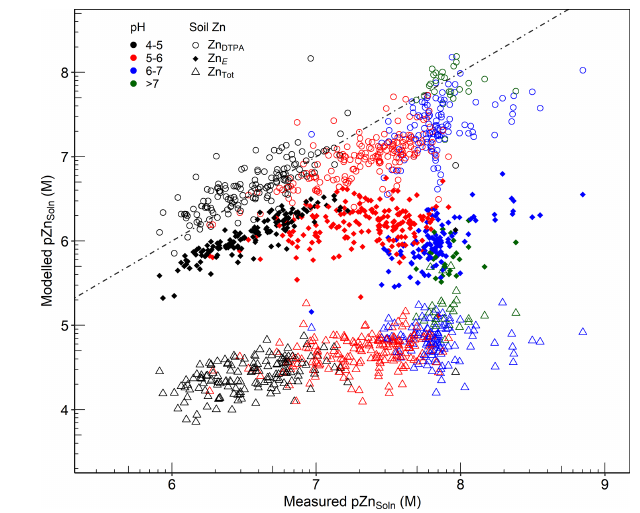
Figure 8. Comparison between observed p Zn Soln ( x axis) and modelled p Zn Soln ( y axis), using either Zn DTPA , Zn E or Zn Tot as WHAM inputs. The dashed line represents the line of